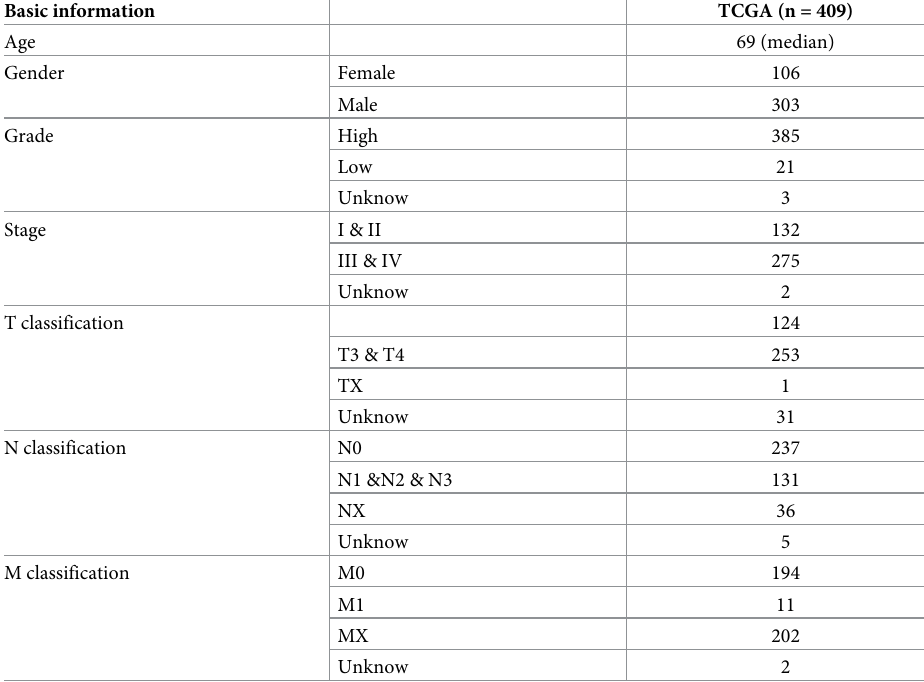
Table 1. Characteristics of the BC patients obtained from the TCGA